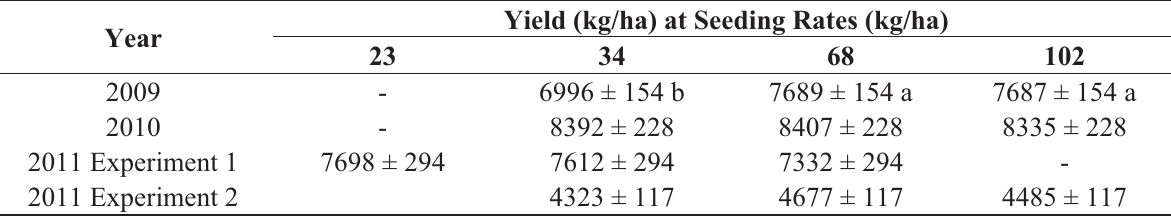
Table 4. Impact of seeding rate on yields harvested from small plot field experiments during 2009–2011 a .